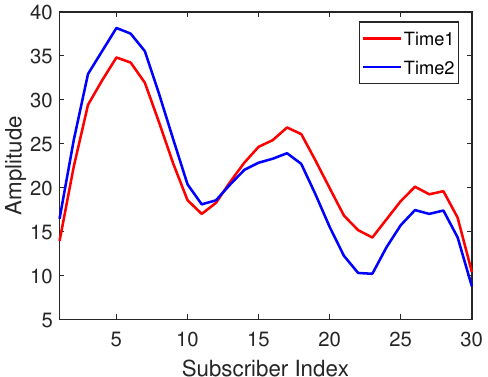
Figure 2. The amplitude waveforms at position #1 under two time